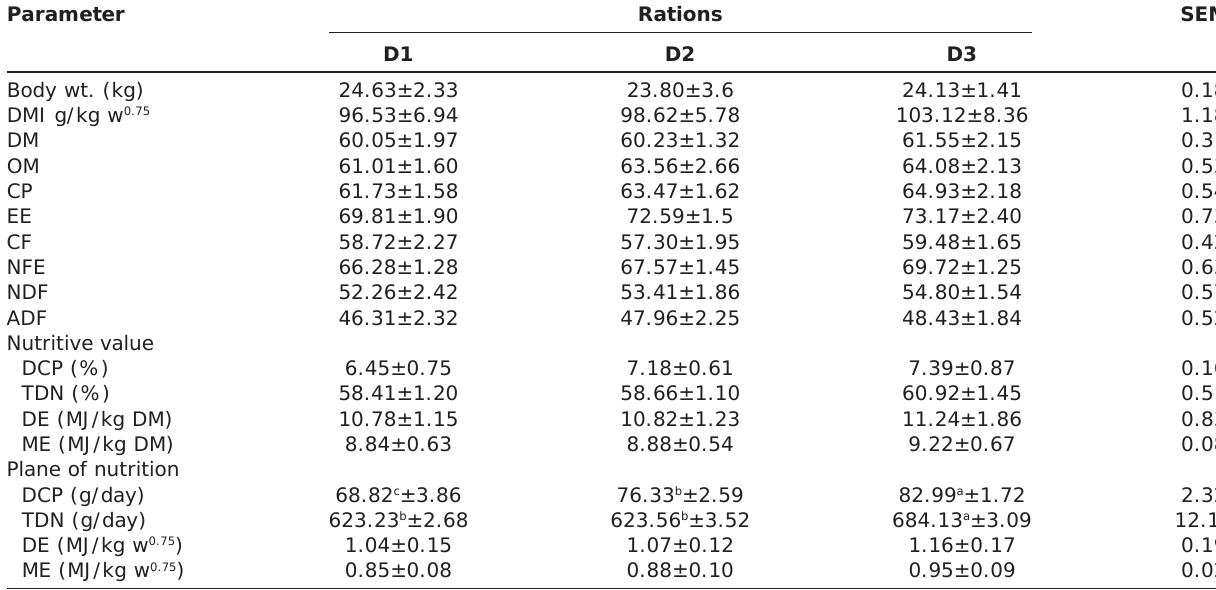
Table-4: Effect of feeding different stover based complete diets on dry matter intake; nutrient digestibility, nutritive value and plane of nutrition in Nellore ram lambs. Parameter